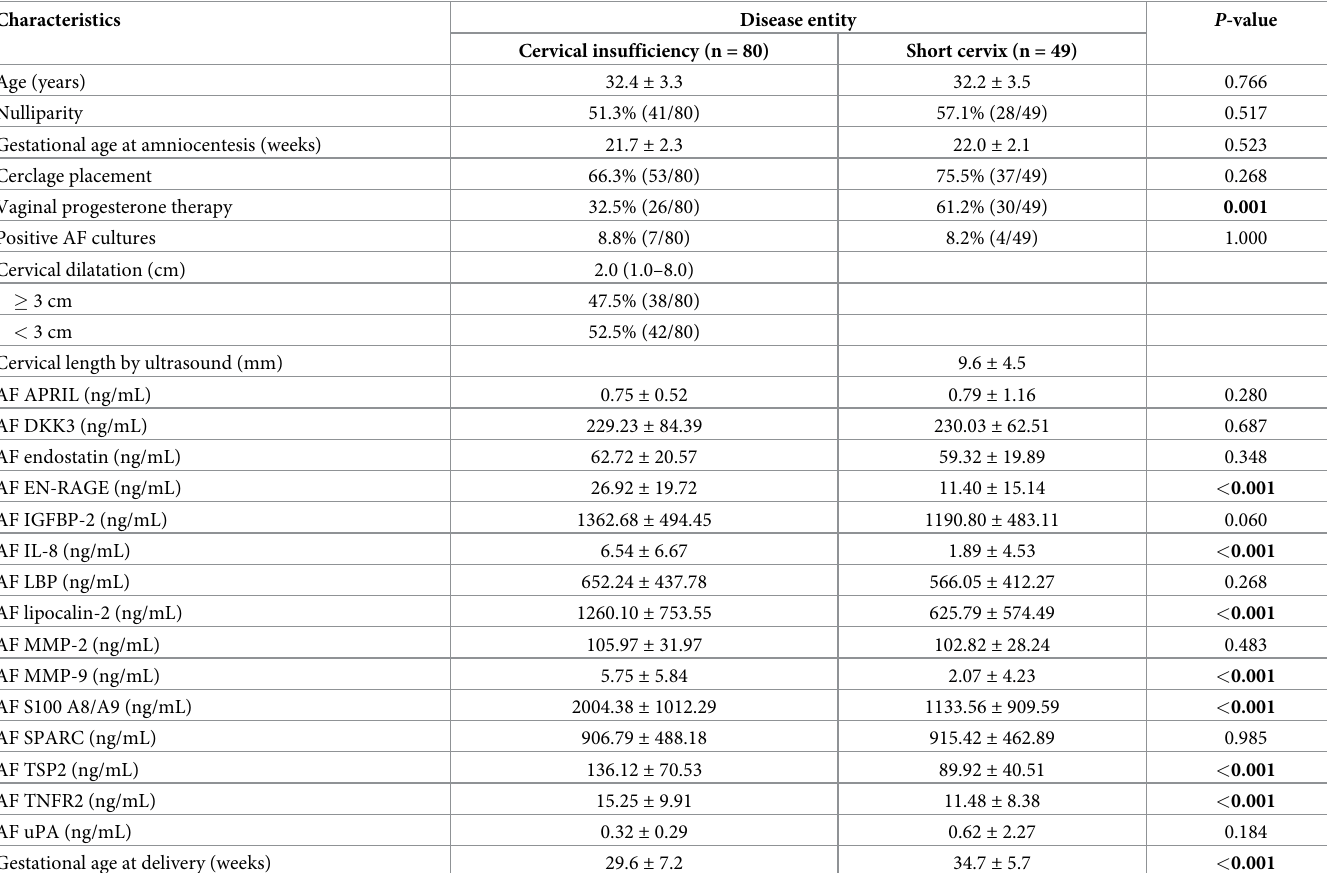
Table 1. Demographic and clinical characteristics, and quantification of the selected candidate biomarkers of interest in women with cervical insufficiency or a short cervix included in the